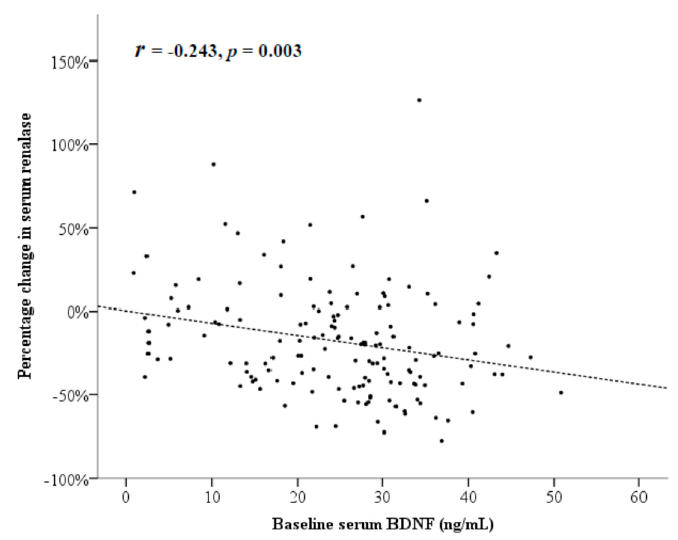
Figure 3. A significant correlation exists between the percentage changes in serum renalase and baseline serum brain-derived neurotrophic factor (BDNF) levels; correlation coefficient ( r ) = − 0.243, p = 0.003.